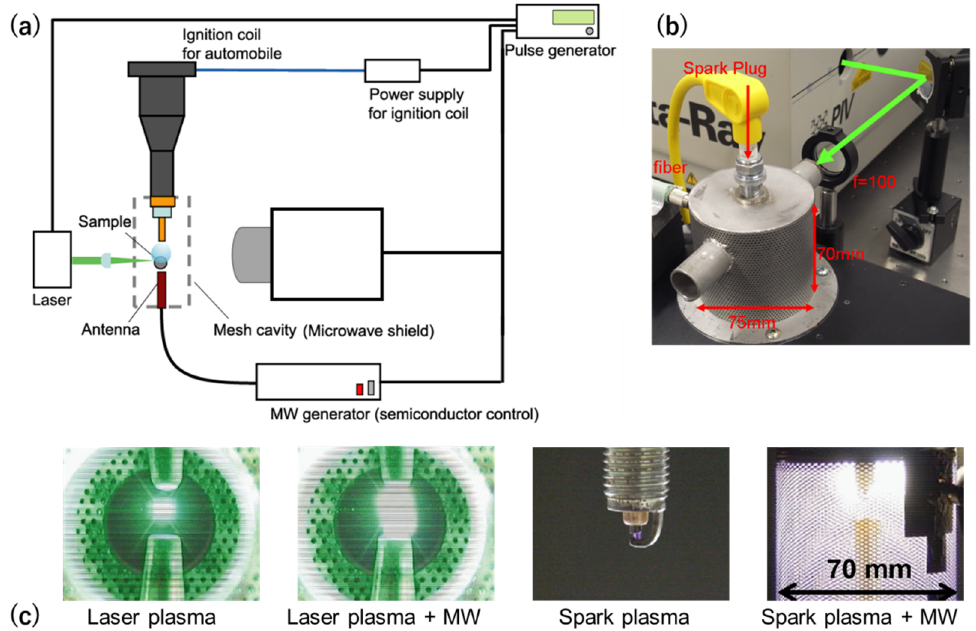
Figure 4. ( a ) Schematic diagram of microwave-enhanced laser ignition system; ( b ) actual image of combustion chamber of spark plug ignition plus microwave. ( c ) Enlargements of plasma plume with superimposition of microwave to laser ignition and spark ignition [22].